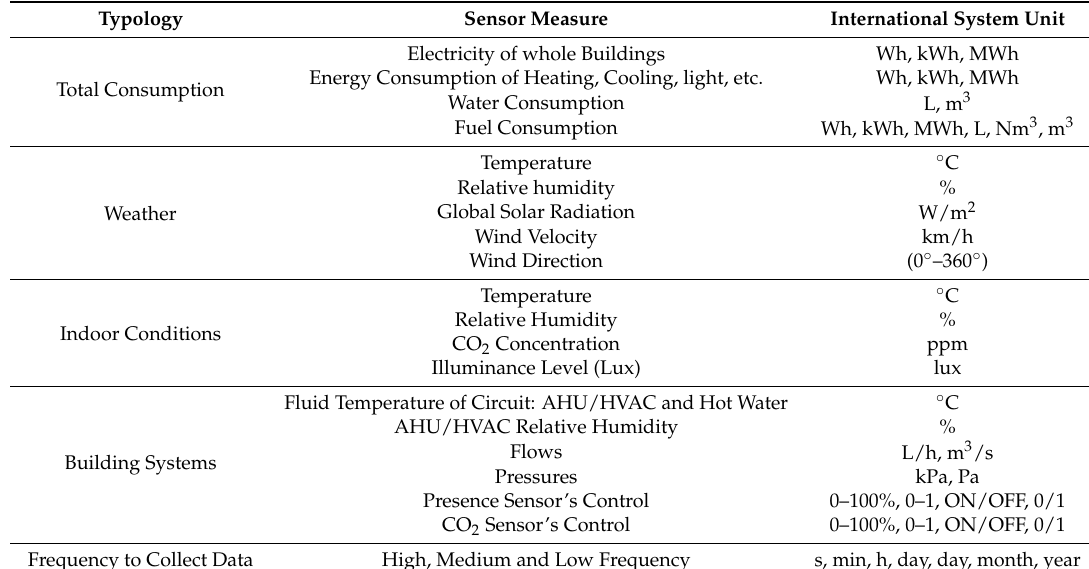
Table 2. The main sensors and meters used for control in building automation based on previous research